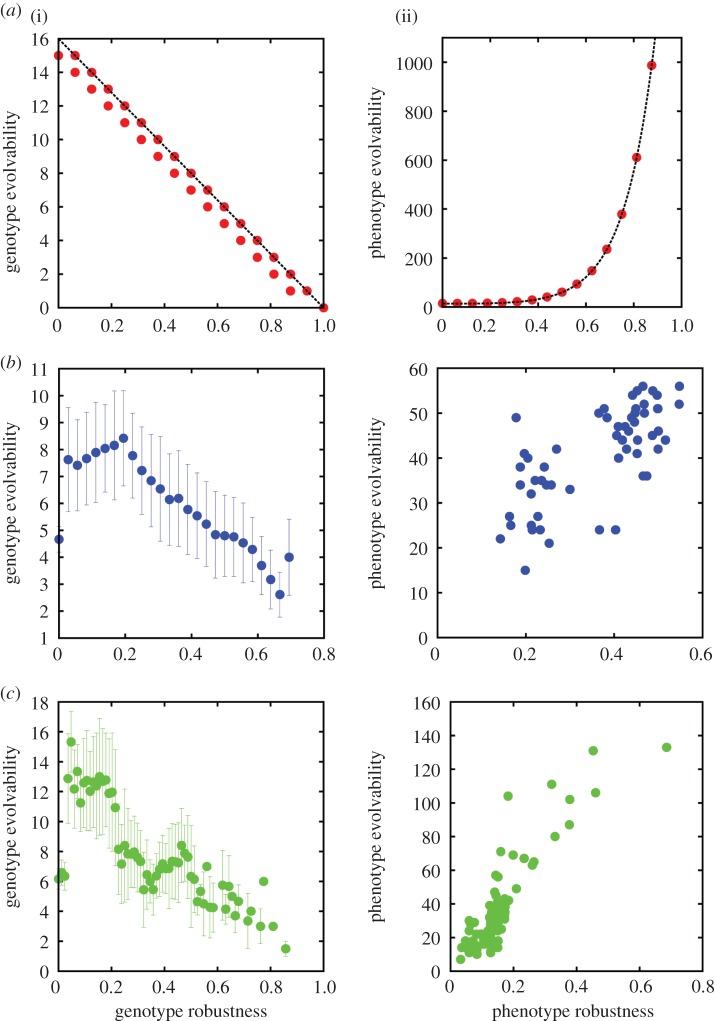
(a) Results for the Fibonacci GP map: (i) genotypic robustness is negatively correlated with genotypic evolvability. (ii) Phenotypic robustness is positively correlated with phenotypic evolvability. Analytical results are shown as black lines, computational results in red. The reason for the ‘stepped’ appearance of the left plot is that eg can be equal to l or l − 1, depending on the presence of a second stop codon. (b) These relationships mirror the same negative (genotypic) and positive (phenotypic) correlations found in RNA L = 12, which are highly statistically significant (p < 10−6). The data are taken from [7]. (c) Polyominoes (here S3,8) display the same behaviour [7] with high statistical significance (p < 10−6). For RNA and polyominoes, the genotype evolvability is averaged for a given value of genotype robustness, and the error bars represent the standard deviations of the evolvabilities for a given value of the robustness. The trivial phenotypes, which are unfolded RNA and unbounded or non-deterministic polyomino tile sets have been removed in this figure.